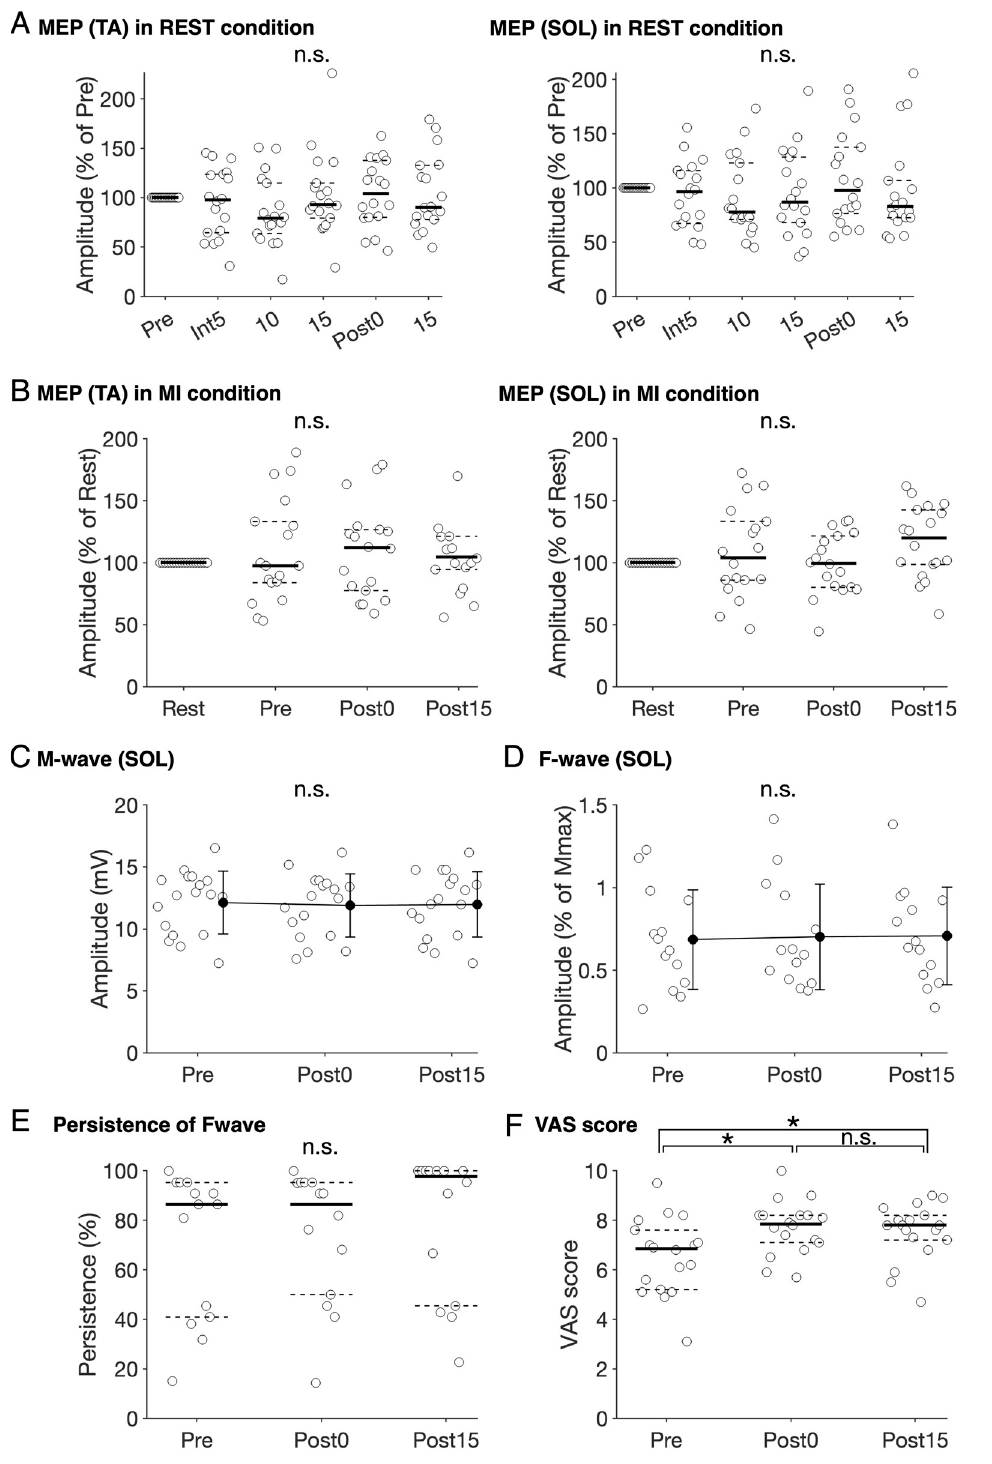
Fig 3. Effects of the intervention on motor evoked potential, F/M, M-wave with the maximum amplitude, and visual analogue scale scores. Changes in the average motor evoked potential (MEP) amplitudes in the tibialis anterior (TA) and soleus (SOL) muscles during the intervention (i.e., after the first block [Int5], second block [Int10], and third block [Int15]) and 0 min and 15 min after the intervention (Post0 and Post15) in the REST condition (A). Each white plot displays the average MEP amplitudes normalized as the percentage of the average MEP amplitudes before the intervention (Pre) in the